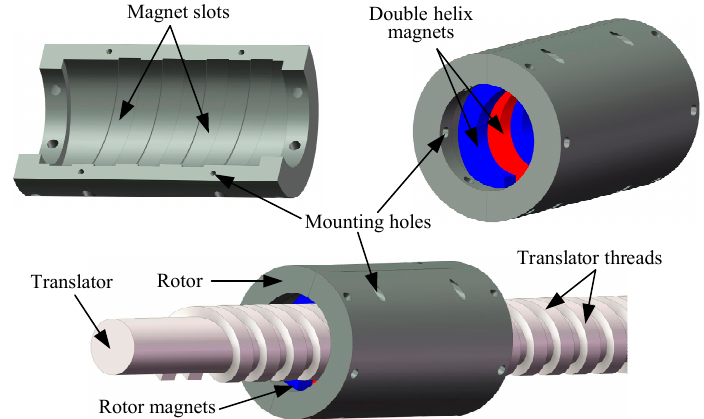
Figure 15. Rotor semi-cylinder, the final rotor installed with PMs, and the final RLS.